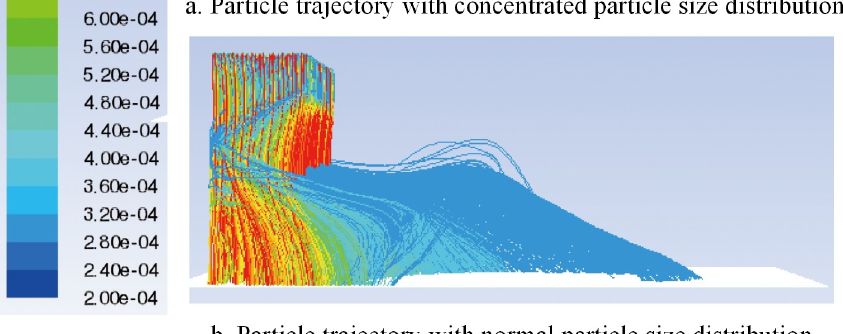
Fig 20. Particle trajectory of different particle size.